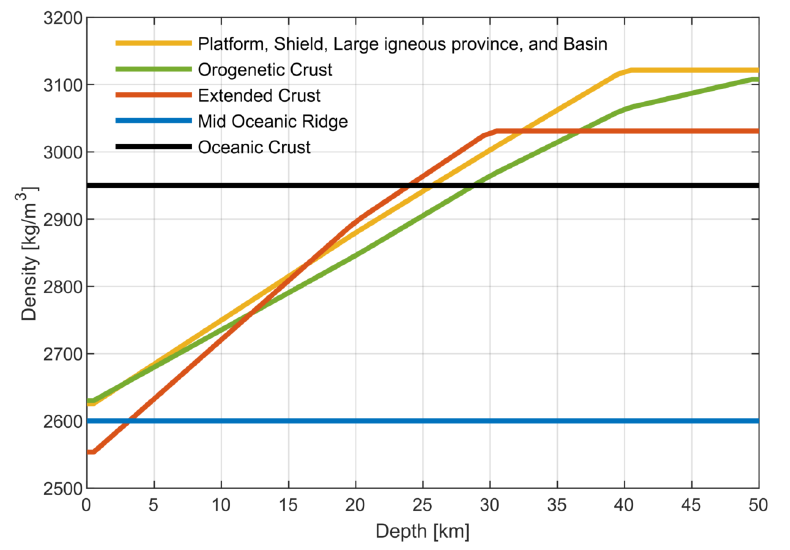
Figure 5. Density profiles of each type of crust used to simulate the observed gravity